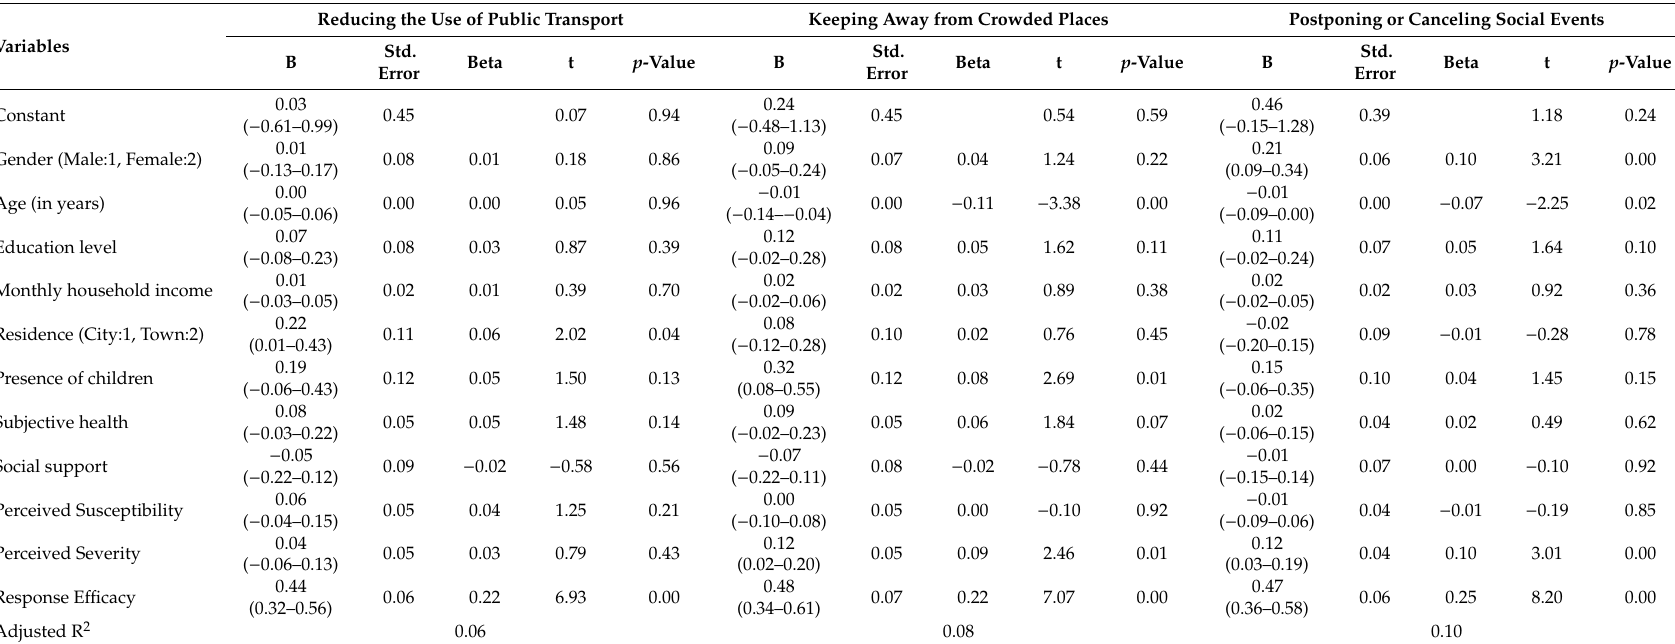
Table 5. Results of multivariate linear regression analysis of social distancing